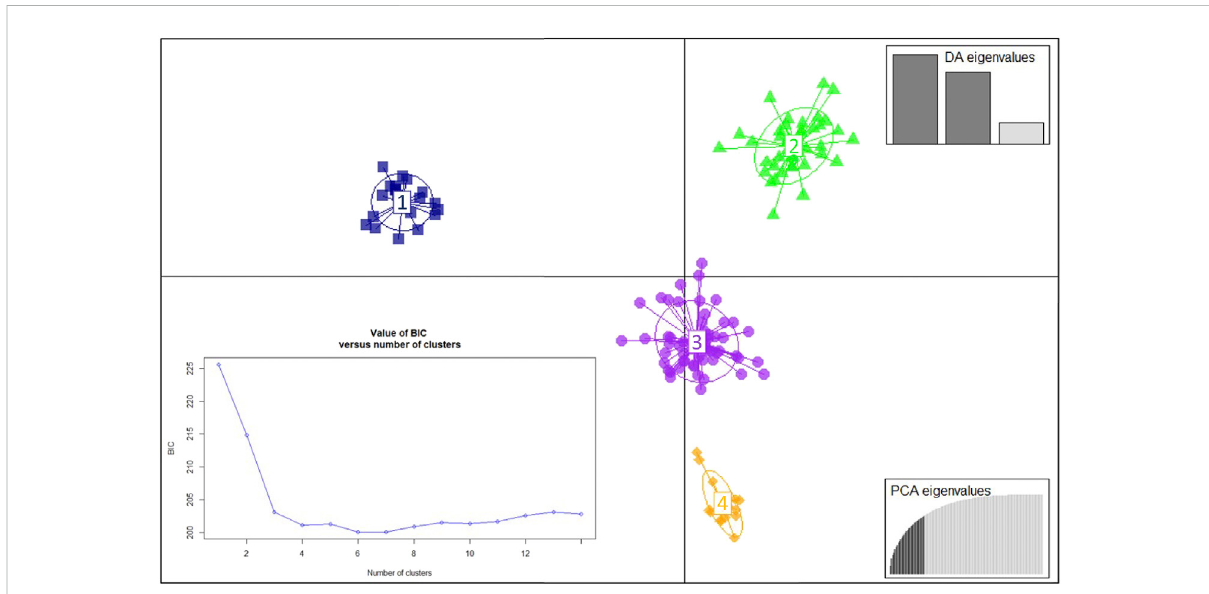
FIGURE 3 Discriminant analysis of principal components (DAPC) for the 135 multilocus genotypes (MLGs) detected among the 192 Puccinia graminis isolates. The Bayesian Information Criterion (BIC) supported four distinct genetic groups (bottom-left inset). The axes represent the fi rst two linear discriminants. Each colored ellipsis represents distinct genetic clusters and symbols individual isolates. associated with unique MLGs. Eigenvalues indicate the amount of genetic information retained by the PCA (bottom-right inset) and the discriminant function (DA, top-right inset).